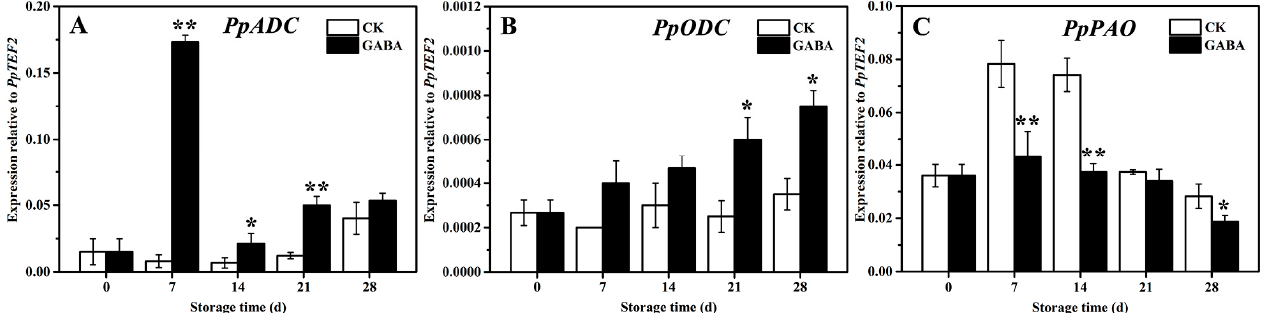
Figure 3. Change in the expression of ( A ) PpADC , ( B ) PpODC , and ( C ) PpPAO in peach fruit induced by GABA. All data are expressed as means ± standard errors (SE). Asterisks (*) indicate significant differences between the GABA and CK groups. Unmatched Student’s t -test; (*) p < 0.05, (**) p < 0.01.